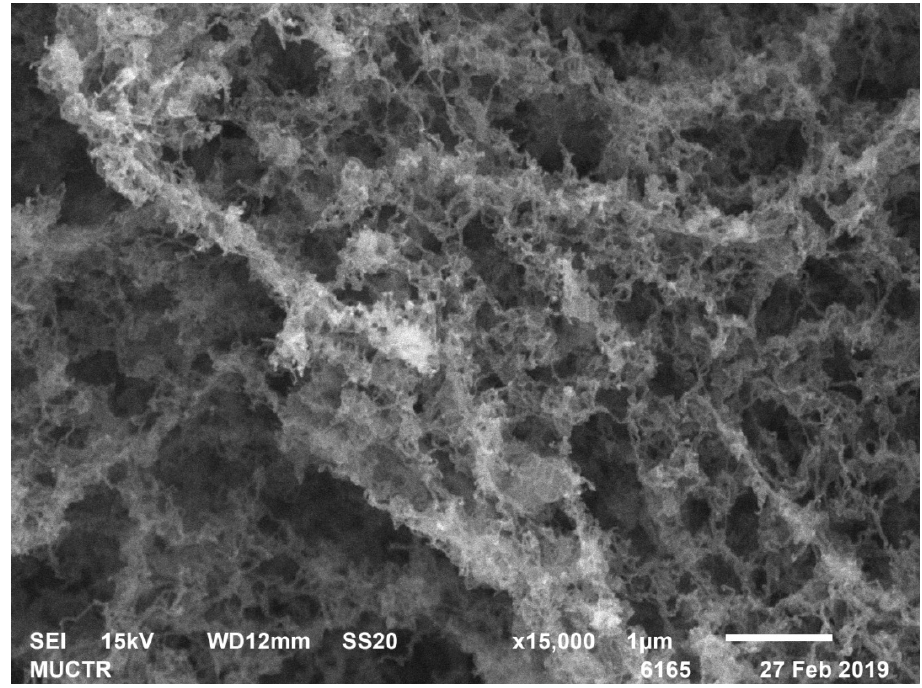
Figure 6. SEM-image of sample 6 chitosan-based aerogel particles.